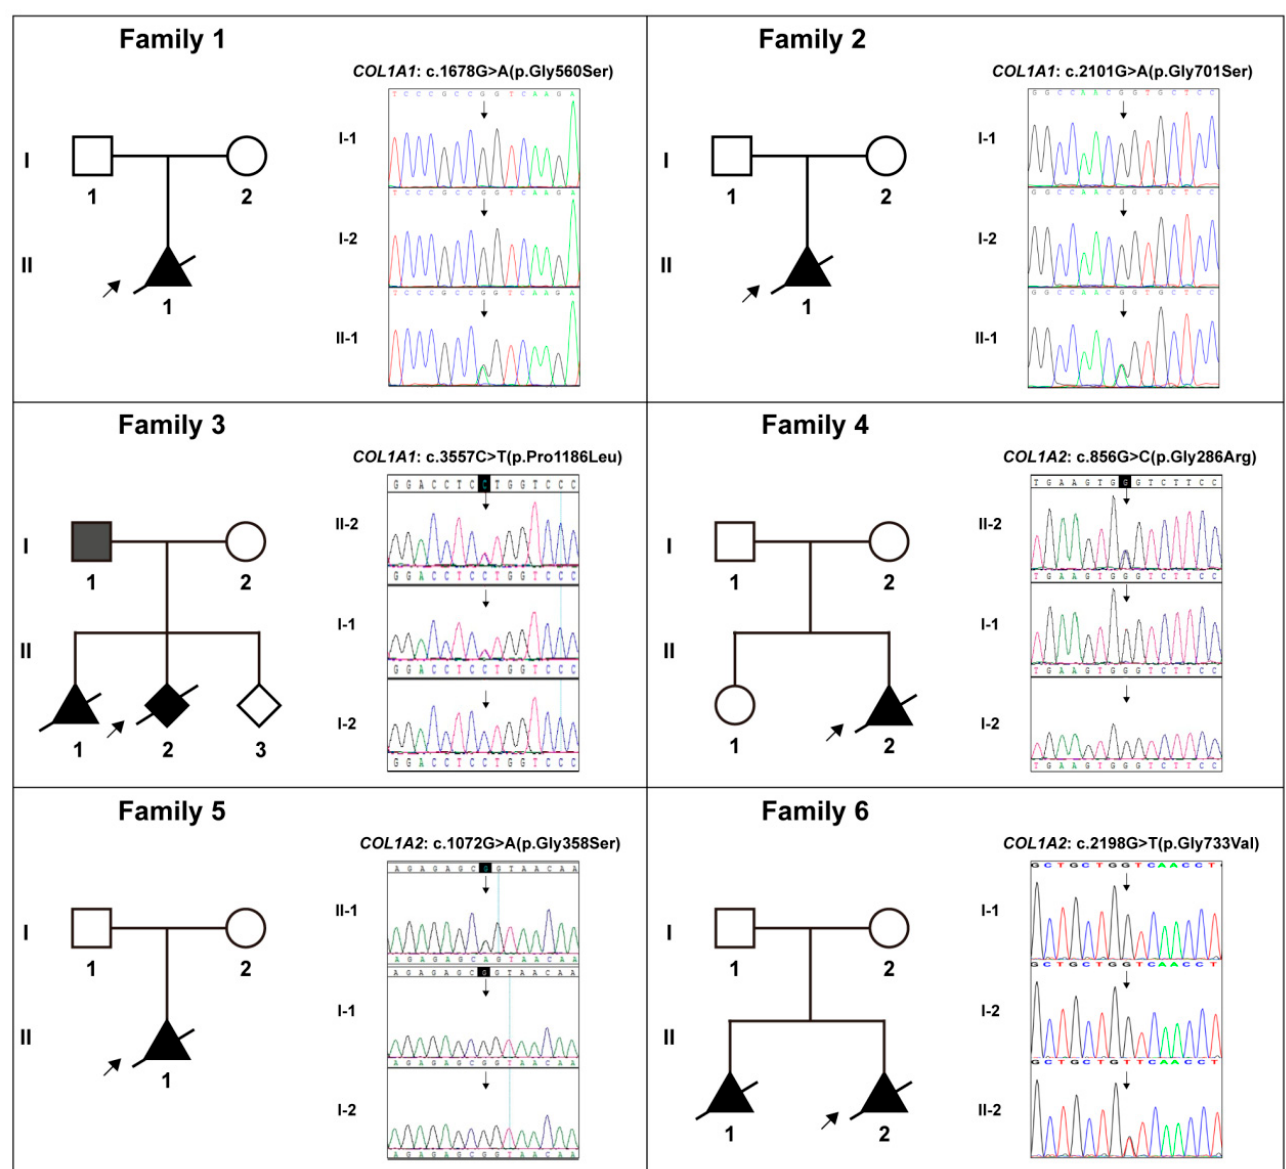
Figure 2. The pedigree diagrams of Cases 1–6 (Families 1–6) and the variants in collagen genes ( COL1A1/2 ) in Sanger sequencing form and their corresponding carrying status in each family. Note: Solid shapes represent mutation carriers; the arrow points to the probands; the diagonal line means dead.